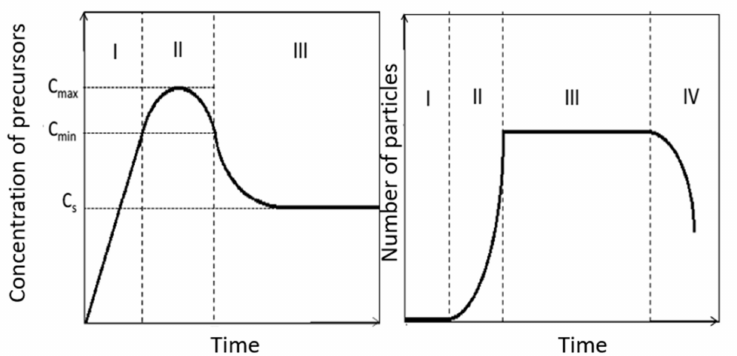
Figure 6. Lamer diagrams representing the concentration of aqua-hydroxo precursors complexes as well as the number in the reaction as a function of time. We can distinguish on these diagrams the different stages of the